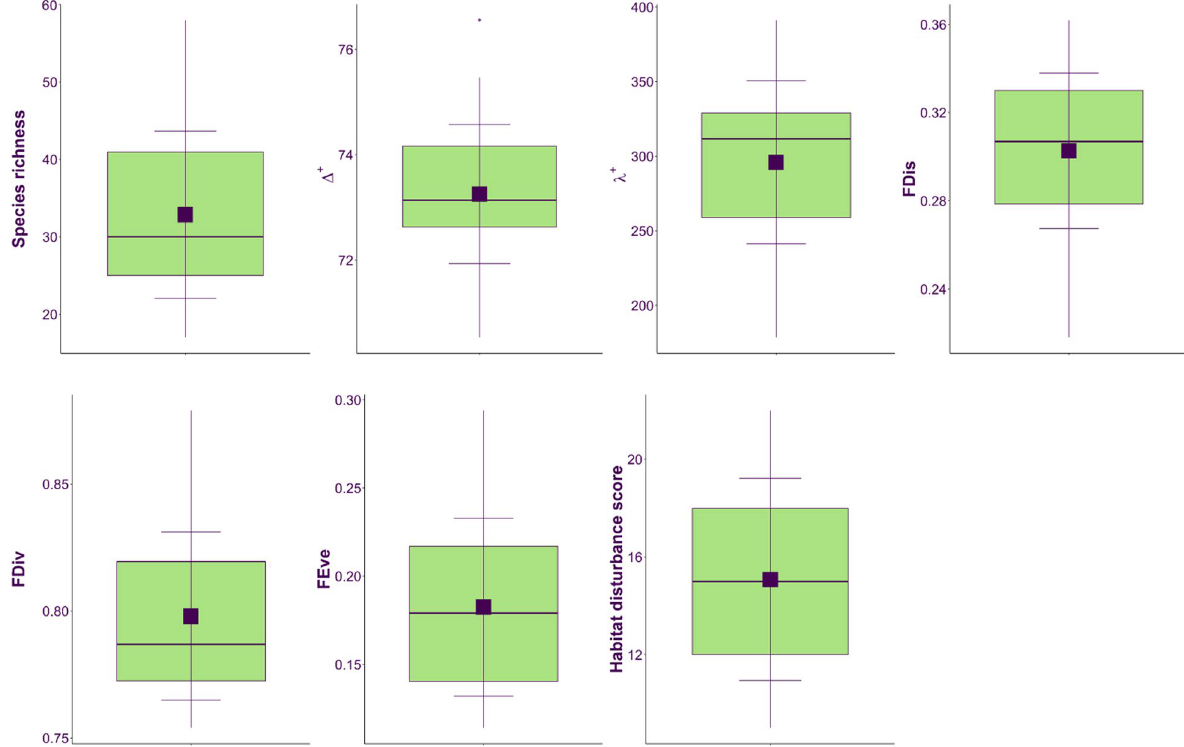
Fig. 2 Boxplots represent a comparative account of species richness (mean SD 32.852 10.801, median 30), index of taxonomic ± = ± = distinctness (Δ + ) (mean SD 73.253 1.322, median 73.138), index of variation in taxonomic distinctness (λ + ) (mean SD 295.995 54.634, ± = ± = ± = ± median 311.785), functional dispersion (FDis) (mean SD 0.303 0.035, median 0.307), functional divergence (FDiv) = ± = ± = (mean SD 0.798 0.033, median 0.787), functional evenness (FEve) (mean SD 0.182 0.051, median 0.787) of the spider community ± = ± = ± = ± = and habitat disturbance score (mean SD 15.074 4.132, median 15) of the 27 sites studied along the Ganga River. Each box represents the ± = ± = 25%/75% quartiles. The mean is shown with a dark square symbol, and the median is shown with a horizontal line. The standard deviation values are shown with short horizontal